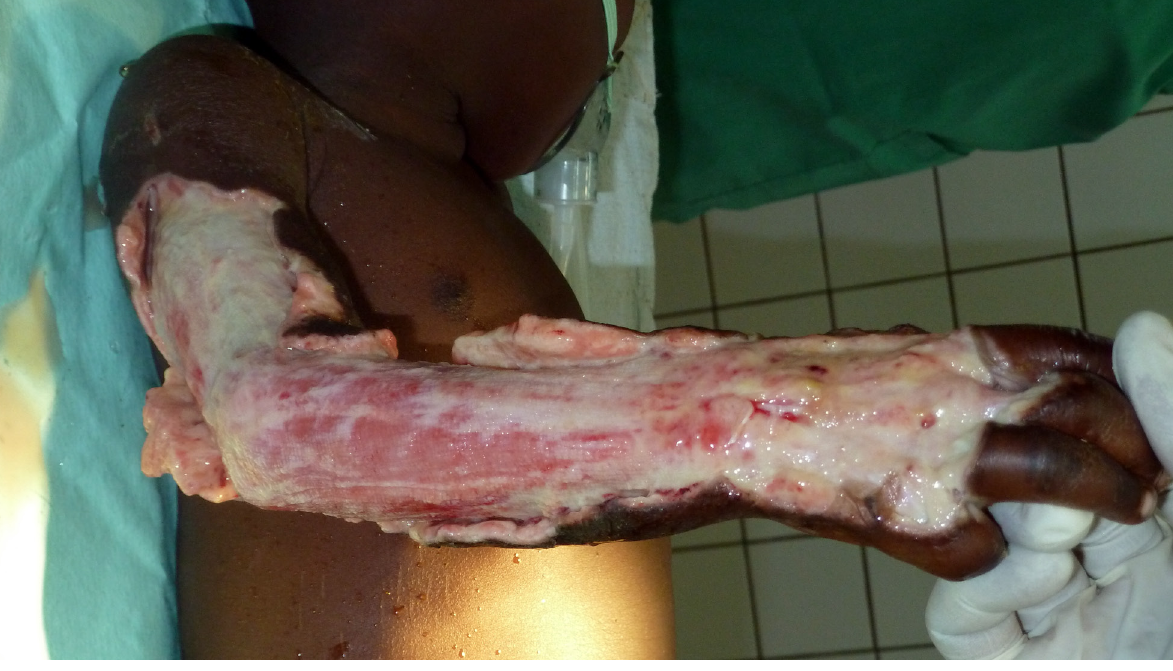
Figure 2 . Initial perioperative